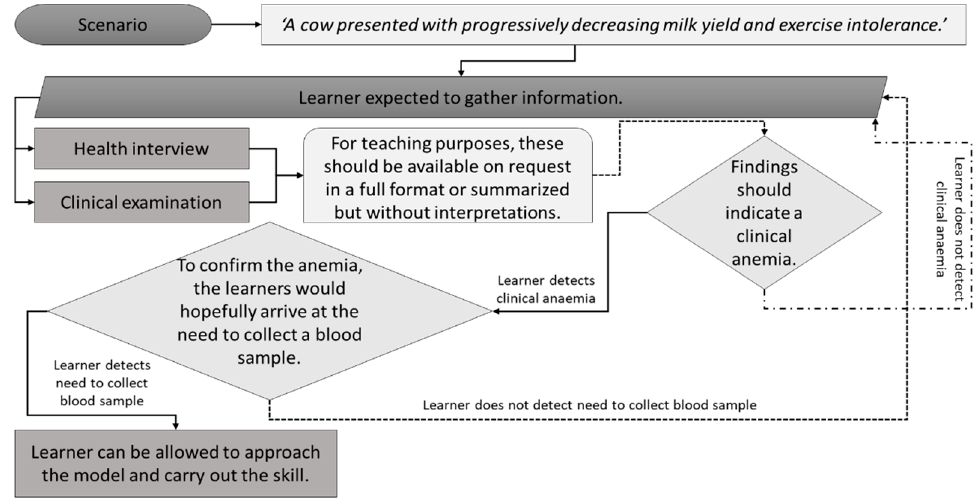
Figure 2. An example of incorporation of a simulation model within a case-based scenario rather than a practical class only using a decision-making algorithm.